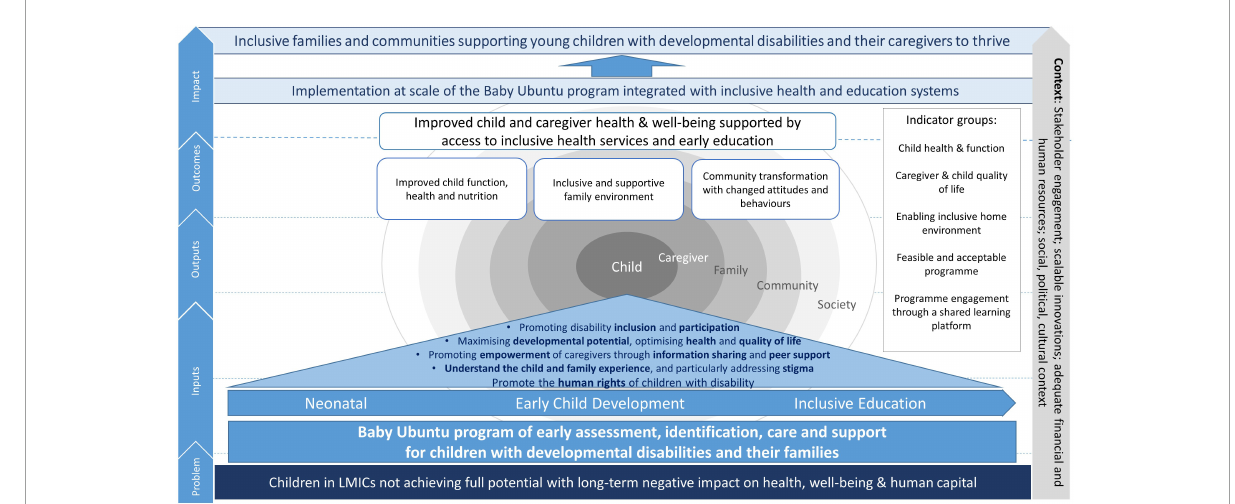
FIGURE1 Conceptual framework for the Baby Ubuntu